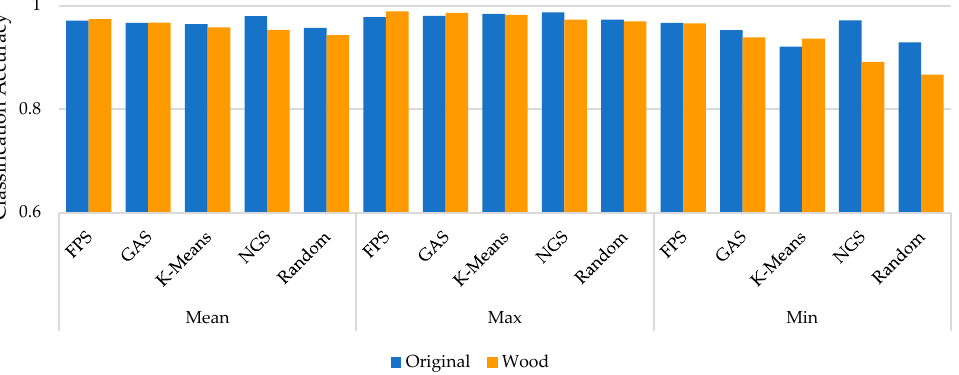
Figure 7. Statistical parameters of classification accuracy of tree species corresponding to different downsampling methods (original: point cloud data without leaf–wood separation; wood: point cloud data of the wood).